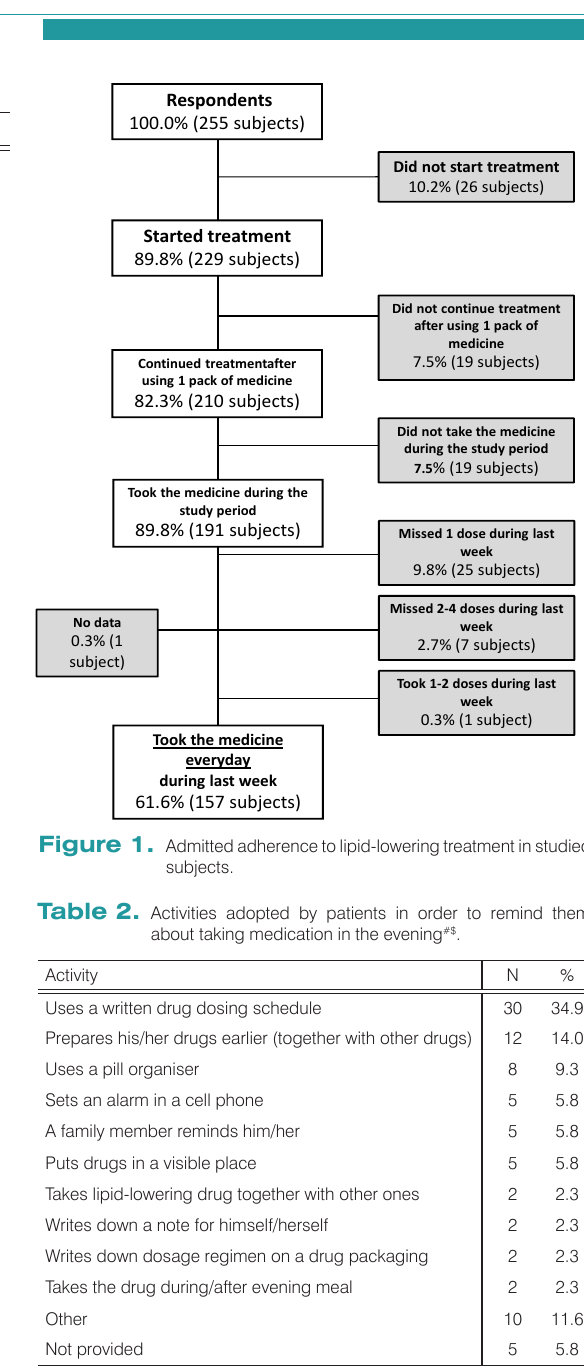
Admitted adherence to lipid-lowering treatment in studied subjects.